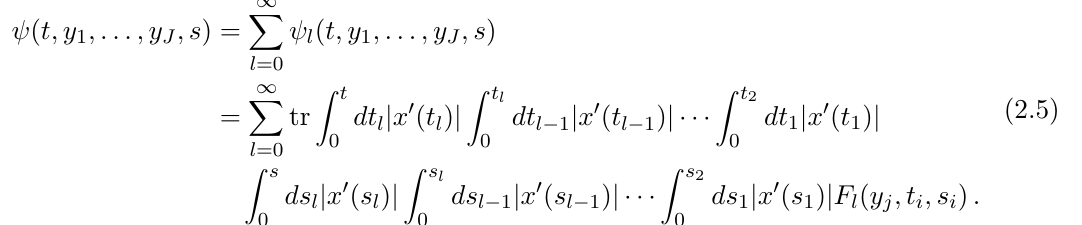
and Z = Φ 5 + i Φ 6 √ . We use the standard 1 2 N Y M